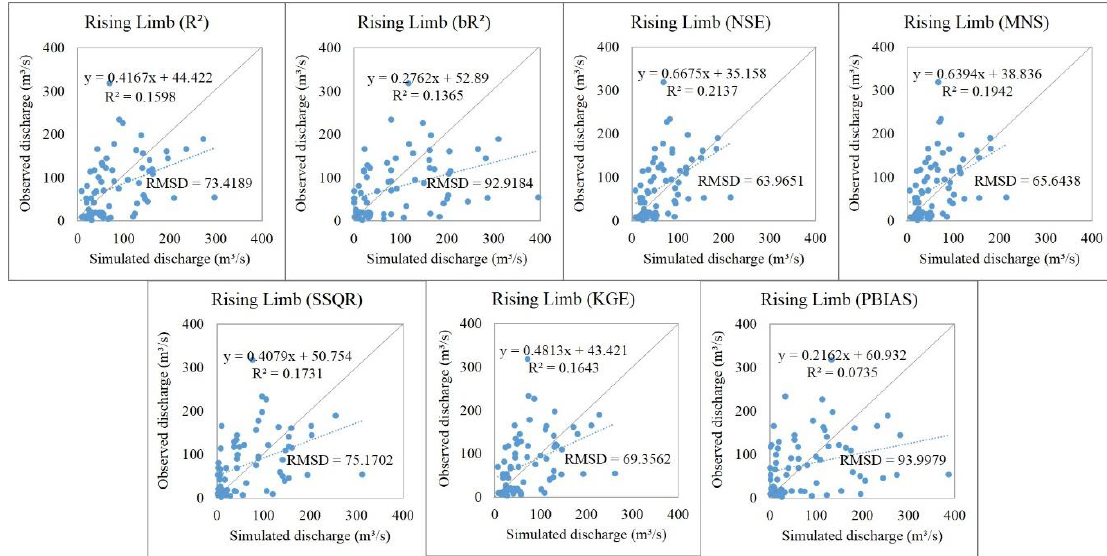
Figure 9. Scatter plots of simulated versus observed rising limb for different objective functions.